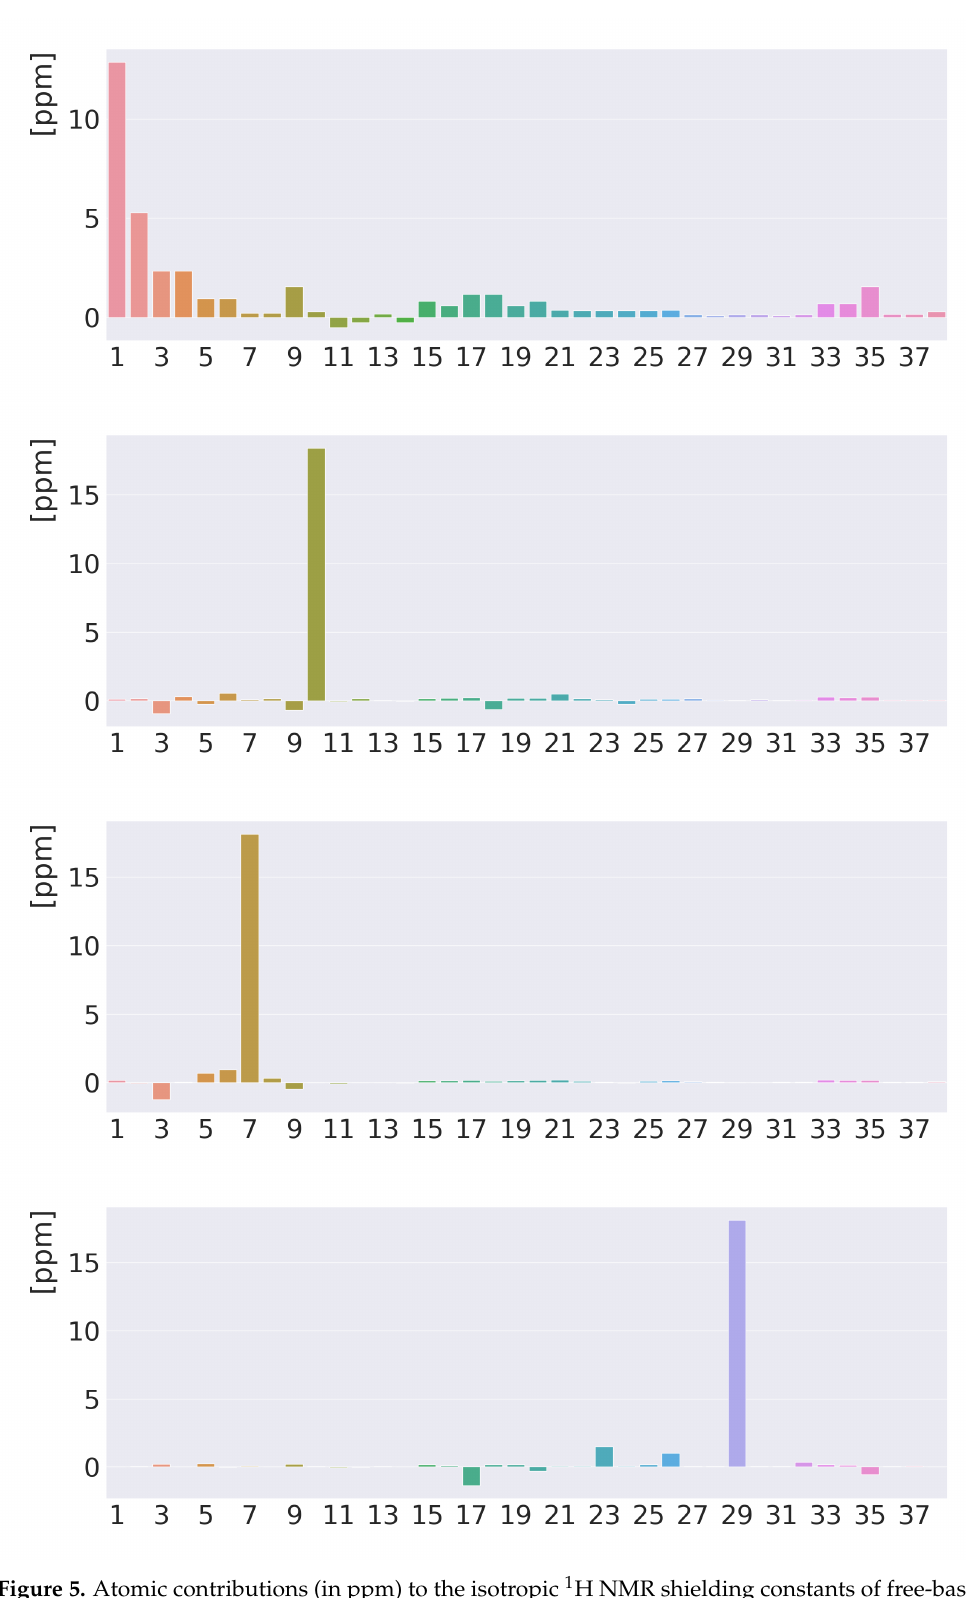
Figure 5. Atomic contributions (in ppm) to the isotropic 1 H NMR shielding constants of free-base trans -porphyrin. From above: the inner hydrogen, the meso hydrogen, the β hydrogen atoms of the pyrrole ring with an inner hydrogen, and the β hydrogen atoms of the pyrrole ring without an inner hydrogen. The atoms are numbered along the x axis in the same order as in the